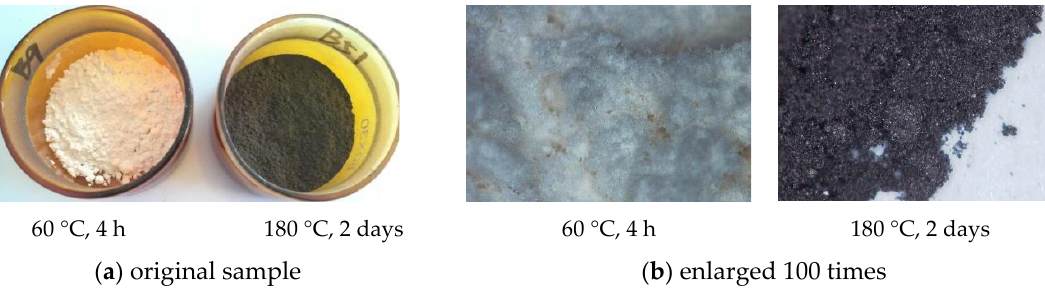
Figure 4. The apparent morphology of TeO 2 before and after different temperature tests.